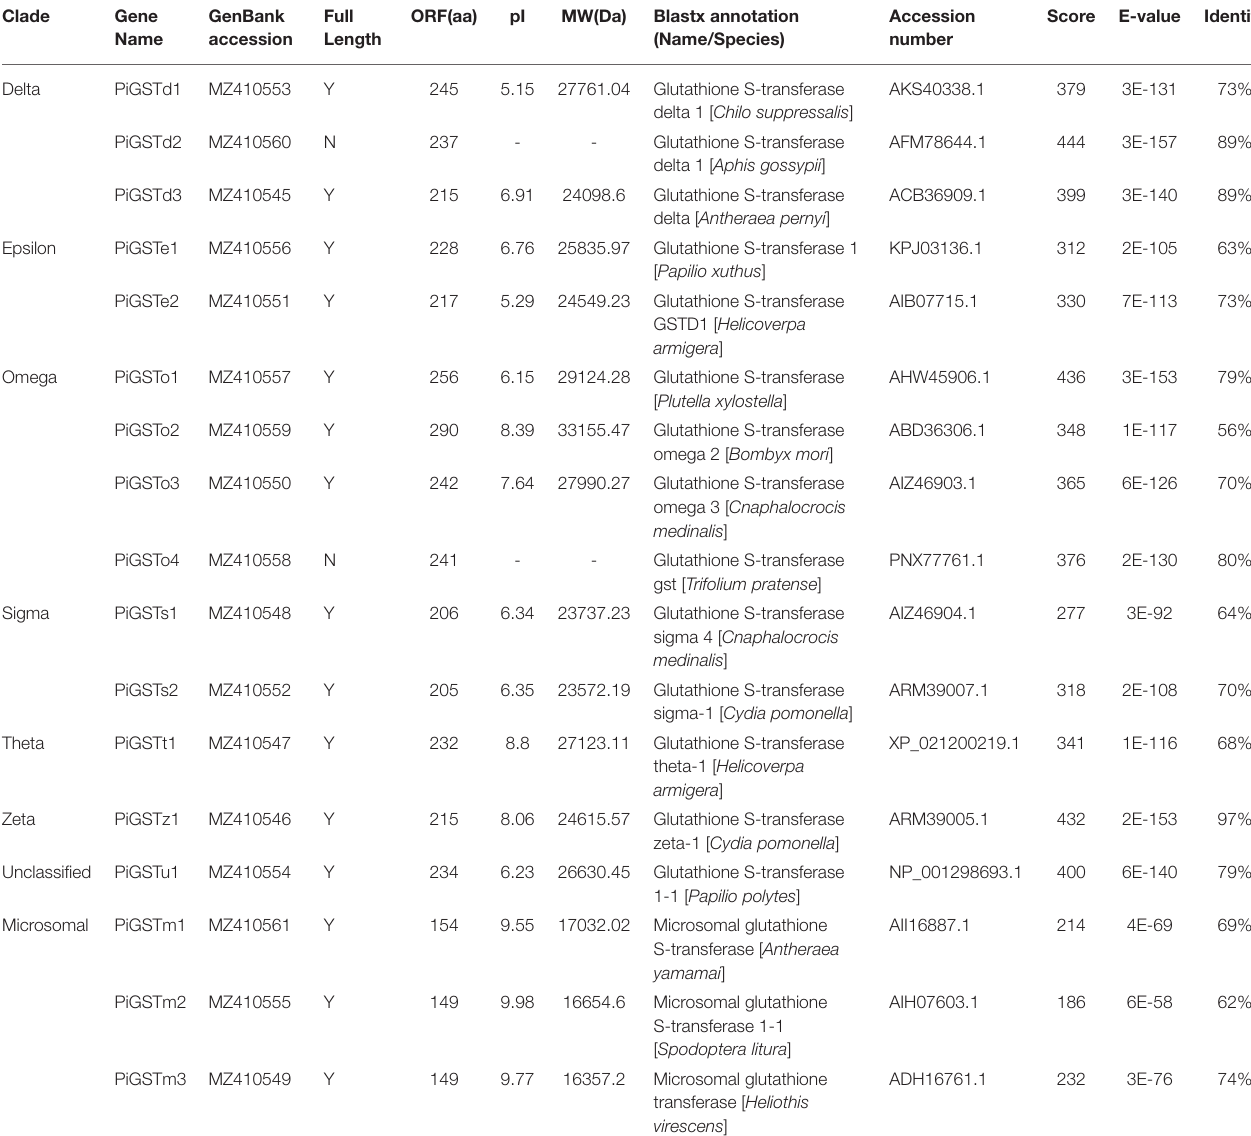
TABLE 1 | Details of the 17 GSTs identified in Plodia interpunctella